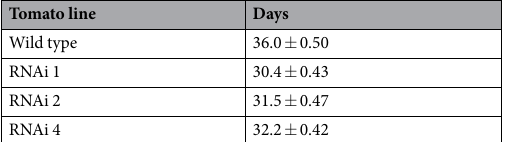
Table 1. Days from anthesis to breaker stage for Wild type and SlHDA1 RNAi lines. 15–20 fruits were examined for biological replicates per line in Table 1.